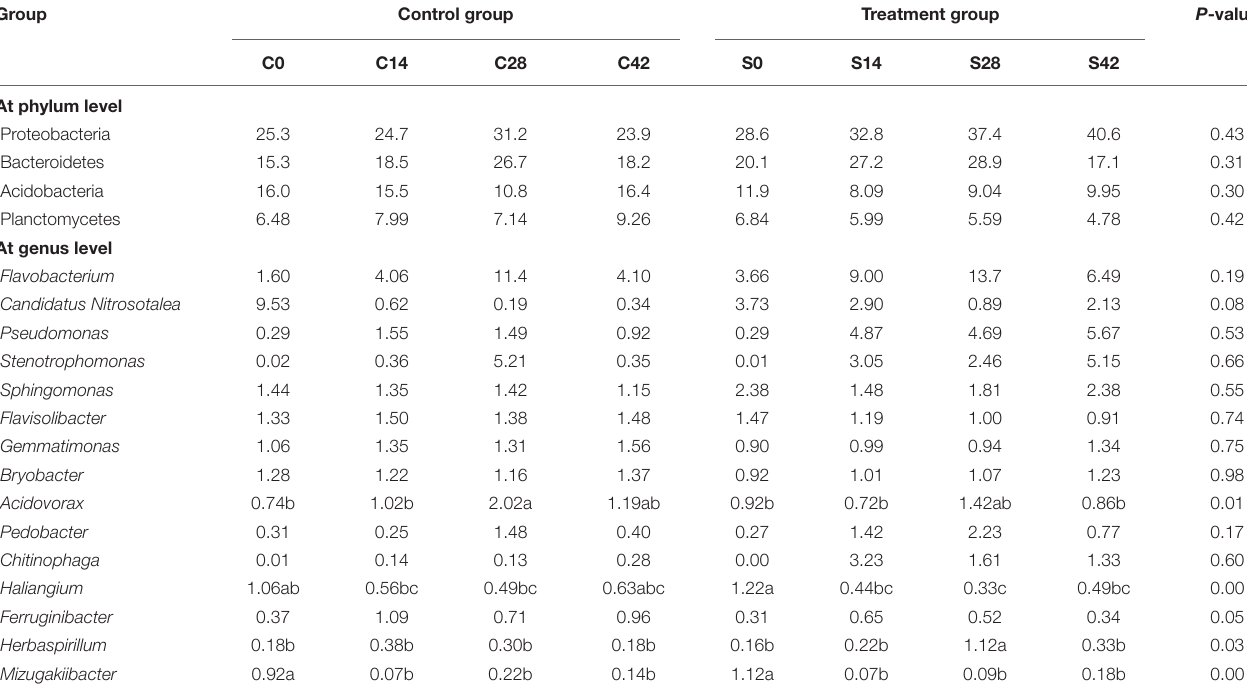
TABLE 3 | Main bacterial groups or the group with significant difference (%). Group Control group Treatment group P